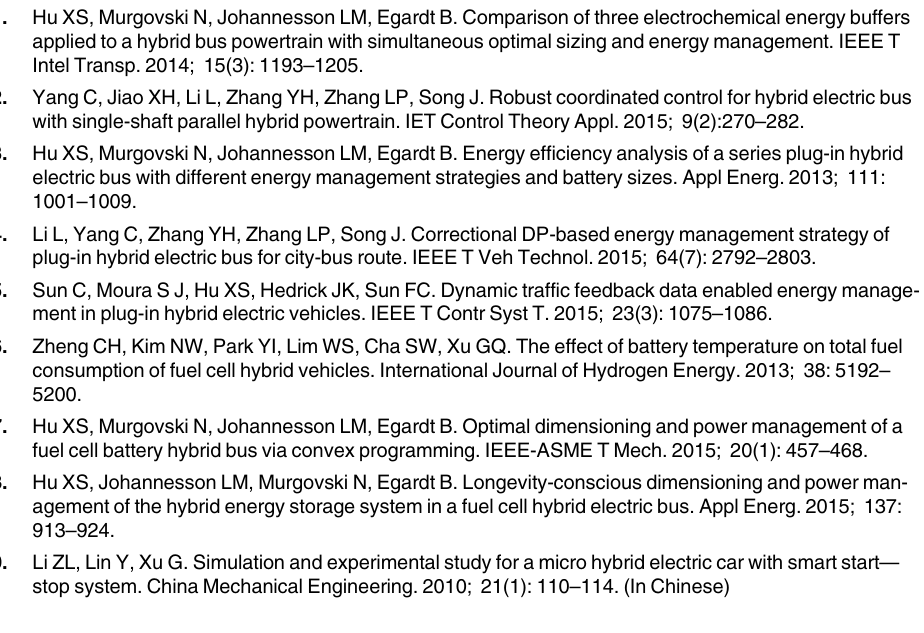
S1 Table. Technical Parameters of the Test Vehicle. S2 Table. Average FCRs of the Test Vehicle for the Test Route. S3 Table. Fuel Consumptions of the Test Vehicle for the Test Route. S4 Table. Fuel Consumptions on Intersections. S5 Table. Fuel Consumption for a Single Intersection. S6 Table. Characteristics of the Test Vehicular Operation and FC on the No. 6